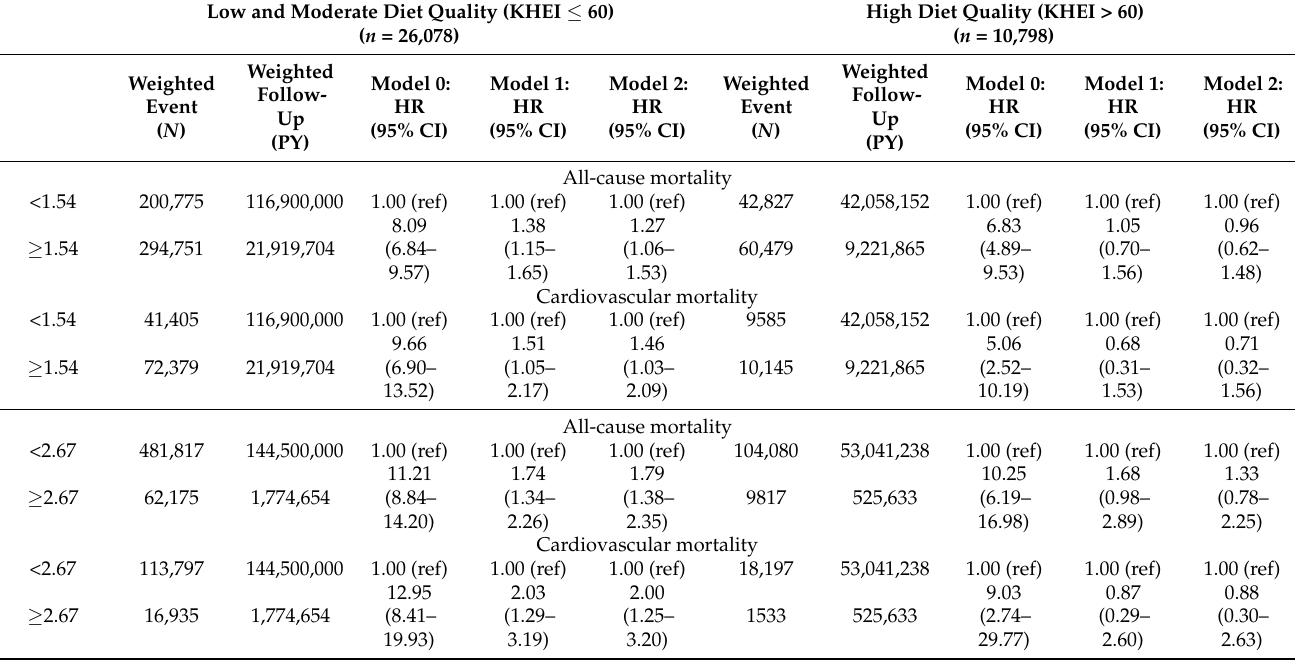
Table 4. Association between advanced liver fibrosis and mortality according to diet